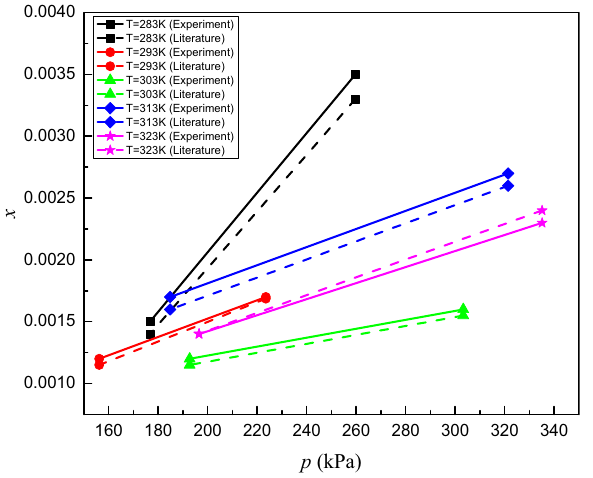
Figure 3. Comparisons of the experimental solubility (mole fraction) of CO 2 in water with data from the literature.